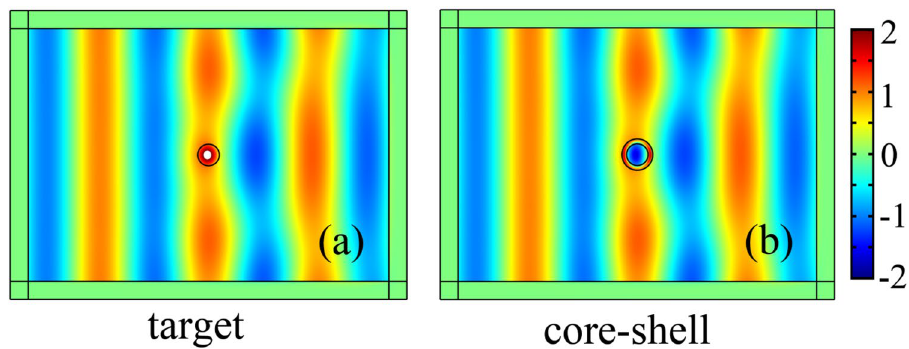
Figure 2. A TE z polarized plane wave with unit magnitude is incident horizontally from the left side. The z -directed magnetic field distributions of the target with parameters r t = λ 0 / 10, ε t = 5 ε 0 and μ t = 1.5 μ 0 (a)